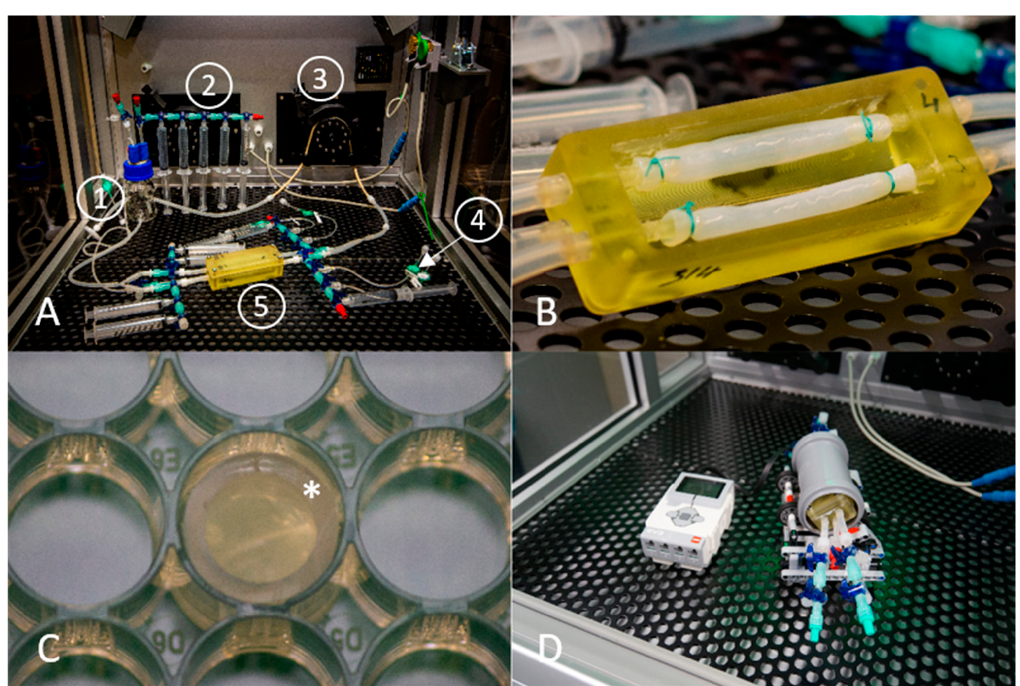
Figure 1. Laboratory setup for dynamic and static endothelialization experiments: ( A ) Perfusion system which was set up in an incubation chamber with controlled atmosphere (5% CO 2 ). (1) Medium reservoir, (2) Syringes for media sampling, (3) Roller pump, (4) 0.2 µ m sterile filter for adding WST-1 cell proliferation assay reagent, (5) 3D printed reactor containing the BNC grafts. ( B ) Enlarged view of the BNC grafts mounted on the 3D printed bioreactor, secured with surgical sutures. ( C ) A piece auf autoclaved PVC tube (*) was added on top of the patch and placed in a 48-well plate to avoid cells running off the BNC patch during the first 24 h of static cultivation. ( D ) Perfusion chamber mounted to a self-made rotation unit. Left: Control unit. Right: The bioreactor was positioned inside a commercially available piece of drain pipe and rotated on the rotation unit to promote cell distribution over the whole BNC graft surface.